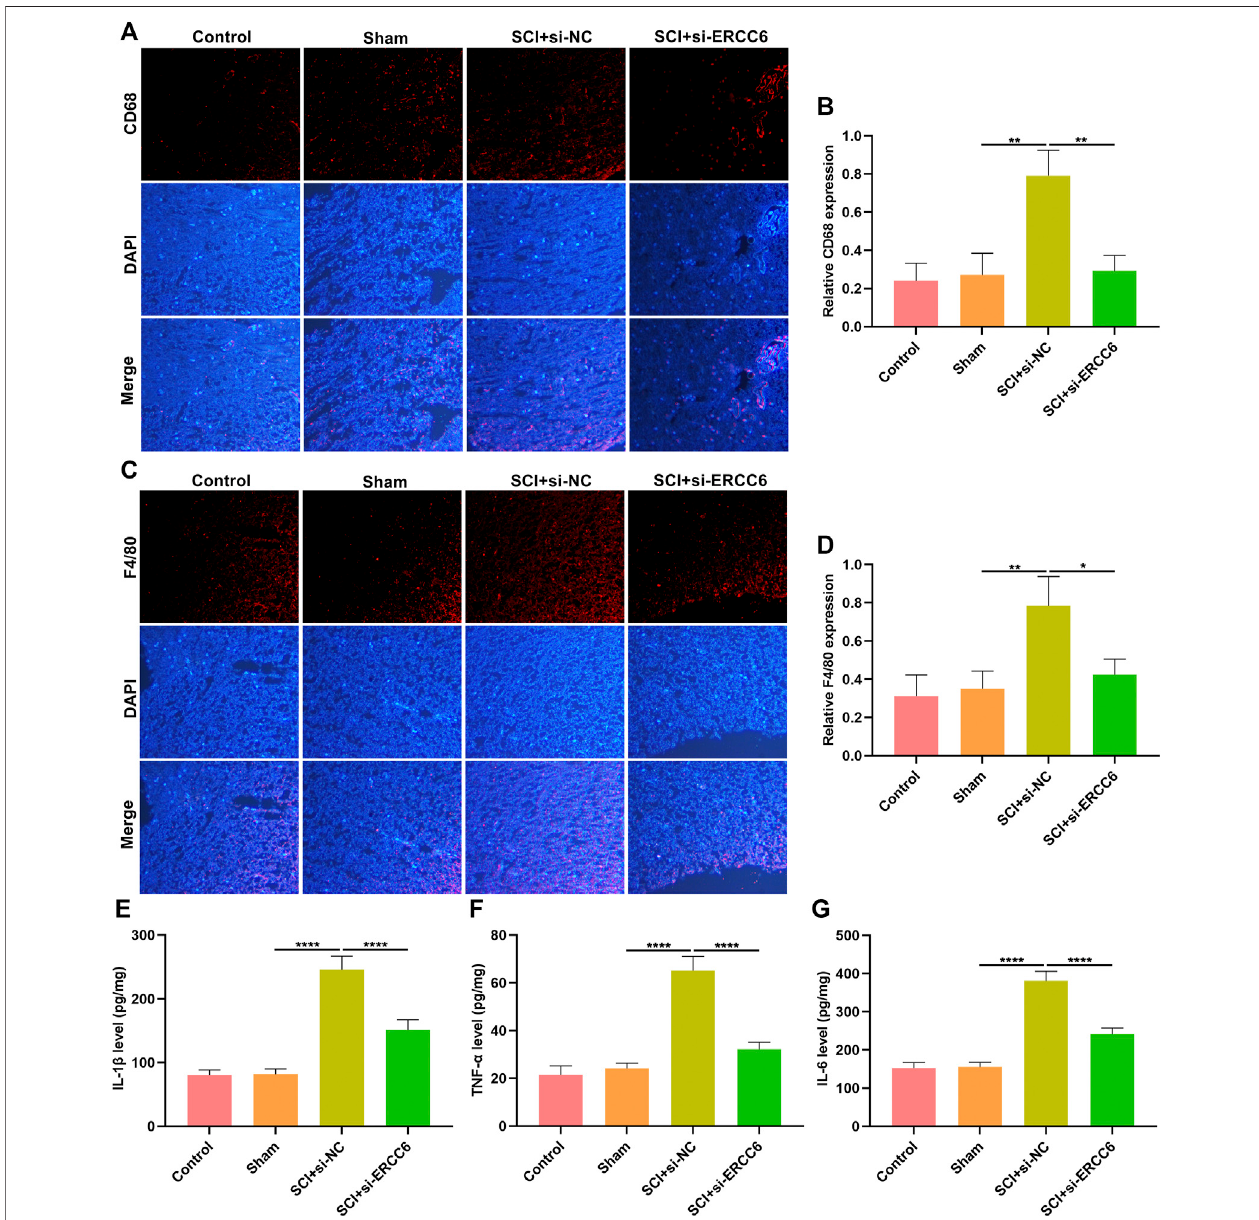
FIGURE 4 | ERCC6 knockdown alleviates in fl ammation in the spinal cord of ICI mice. (A,B) Immuno fl uorescence staining of CD68 expression in the damaged spinalcordofmousemodelsinjectedbysi-ERCC6 orsi-NCaswellascontrolandshamoperationmice(scalebar,50 μ m). (C,D) Immuno fl uorescencestainingofF4/80